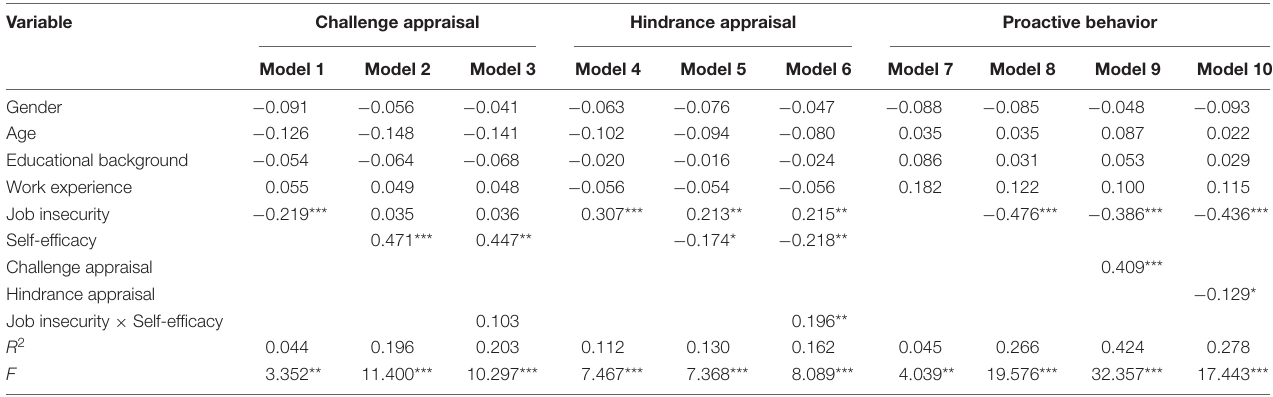
TABLE 5 | Hierarchical regression analysis. Variable